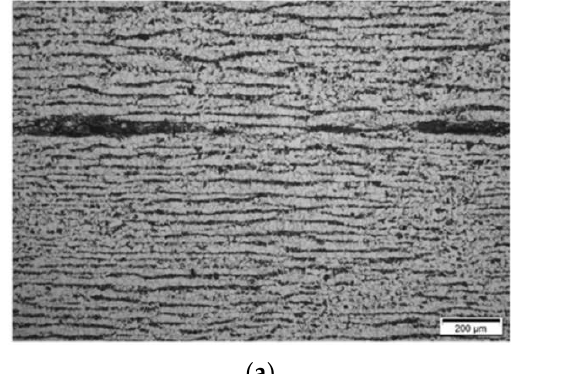
Figure 24. Section No2: 90–140. Coordinate 130 mm, 8.8 mm from ID, straight cracking in pearlite bands, magnification 100× ( a ), 500× ( b ).